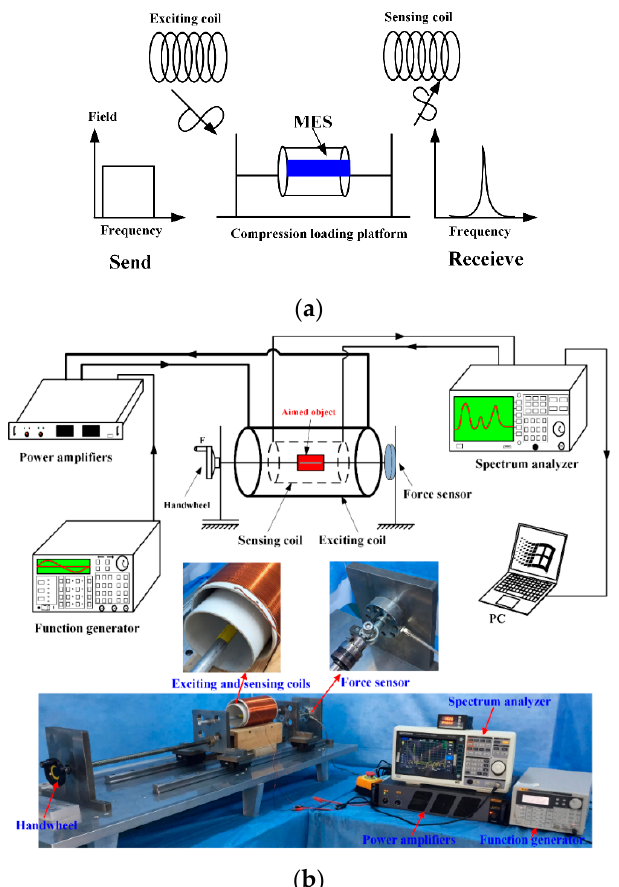
Figure 3. ( a ). Working principle and basic measure devices of the magnetoelastic sensor (MES). ( b ). Self-developed experimental platform and devices. Aimed object including MES is fixed on the platform and surrounded by the sensing coil and the exciting coil. Red color represents the aimed object including MES.